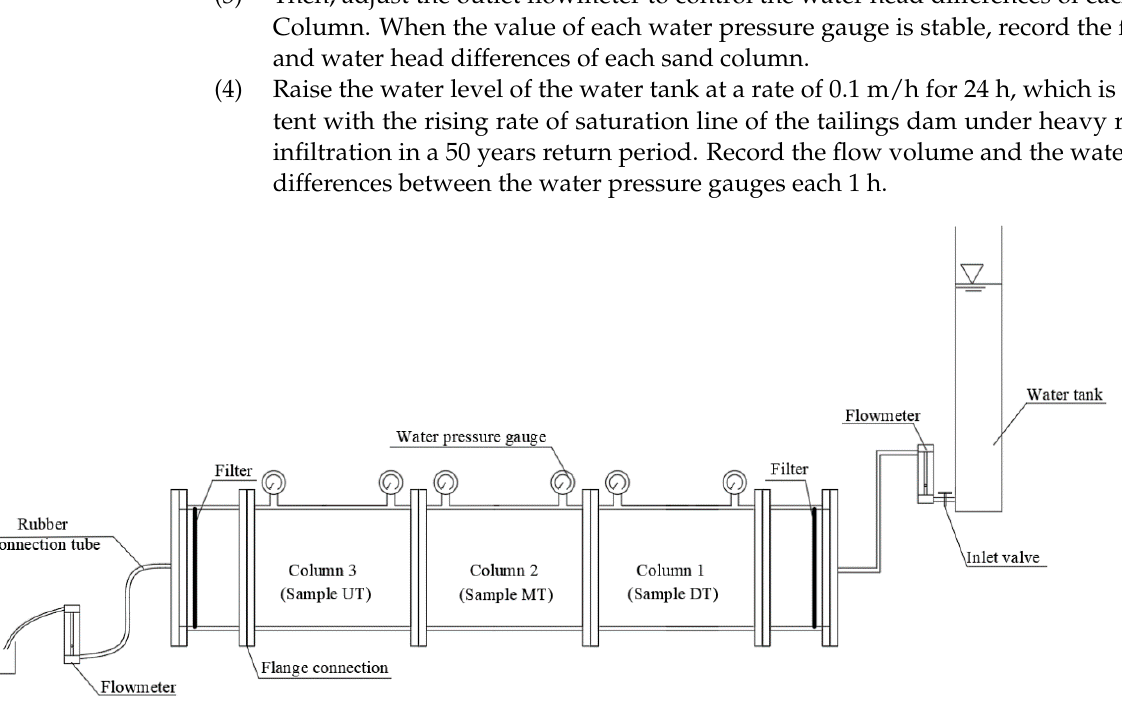
Figure 7. Schematic diagram of unsteady seepage model.